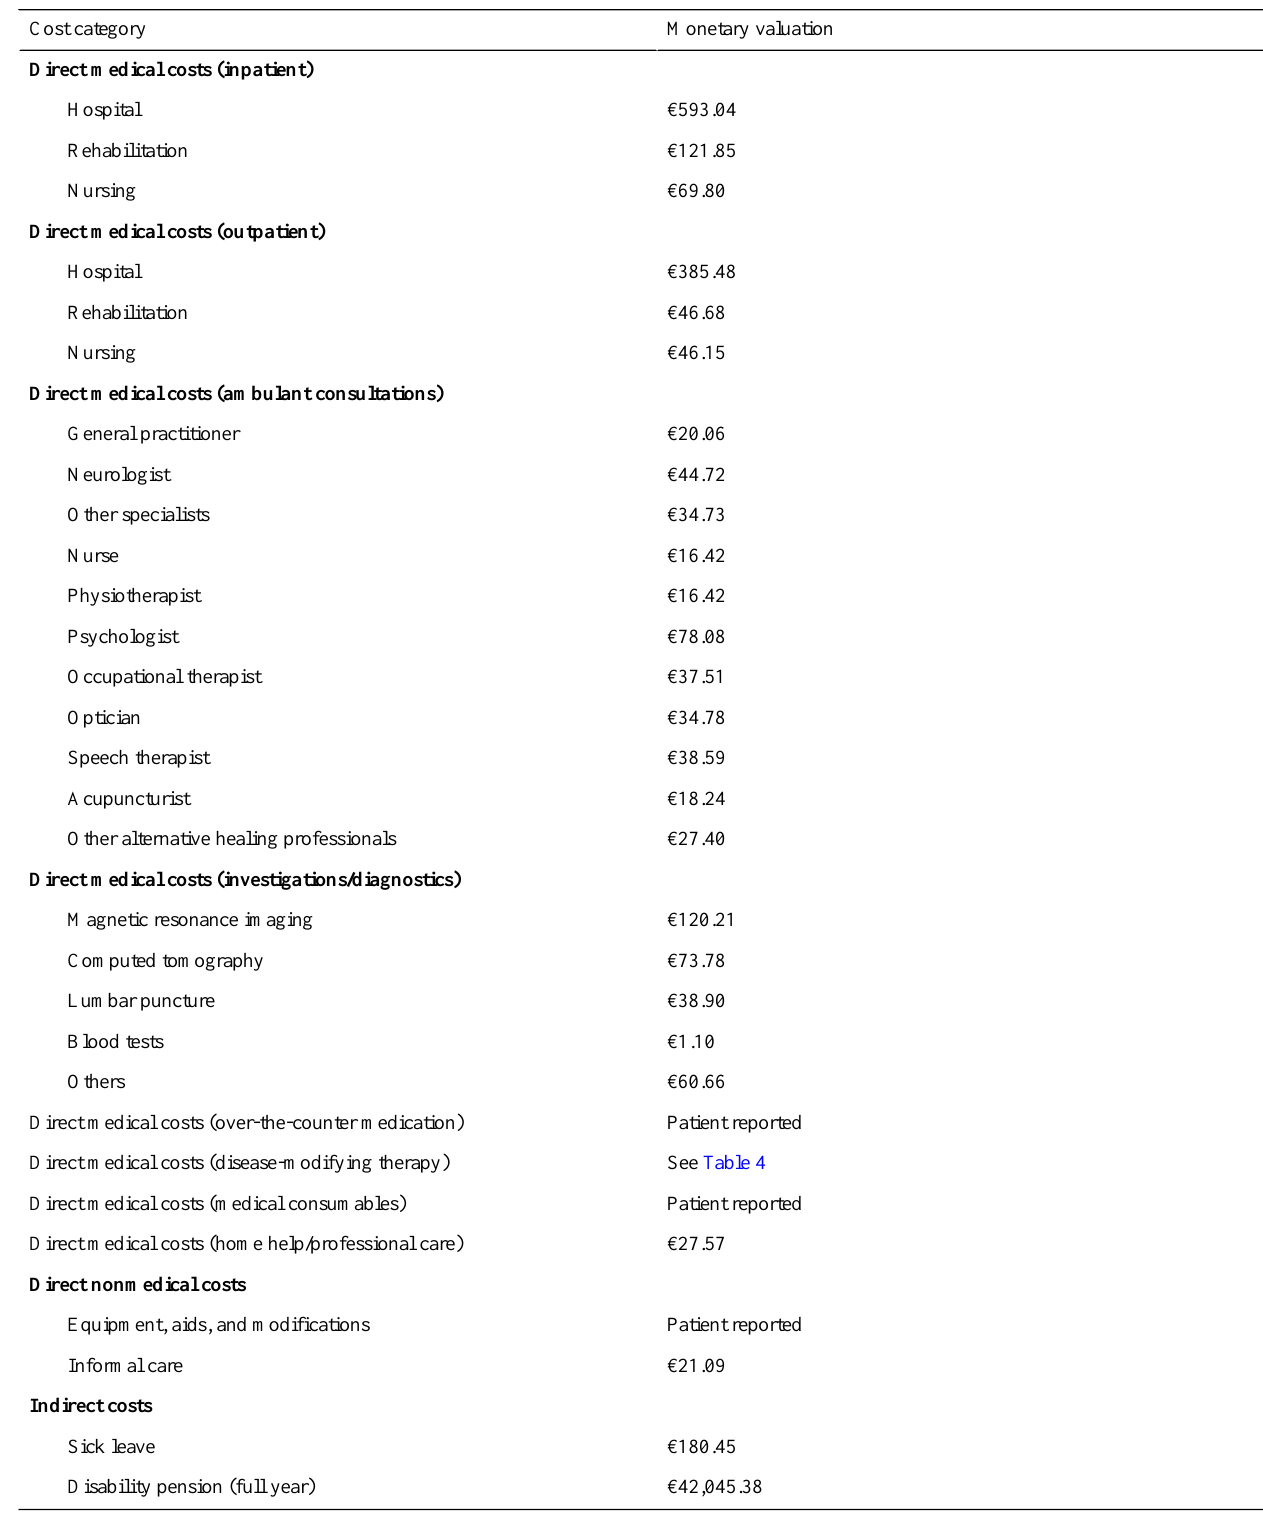
Table 3. Resource valuation per